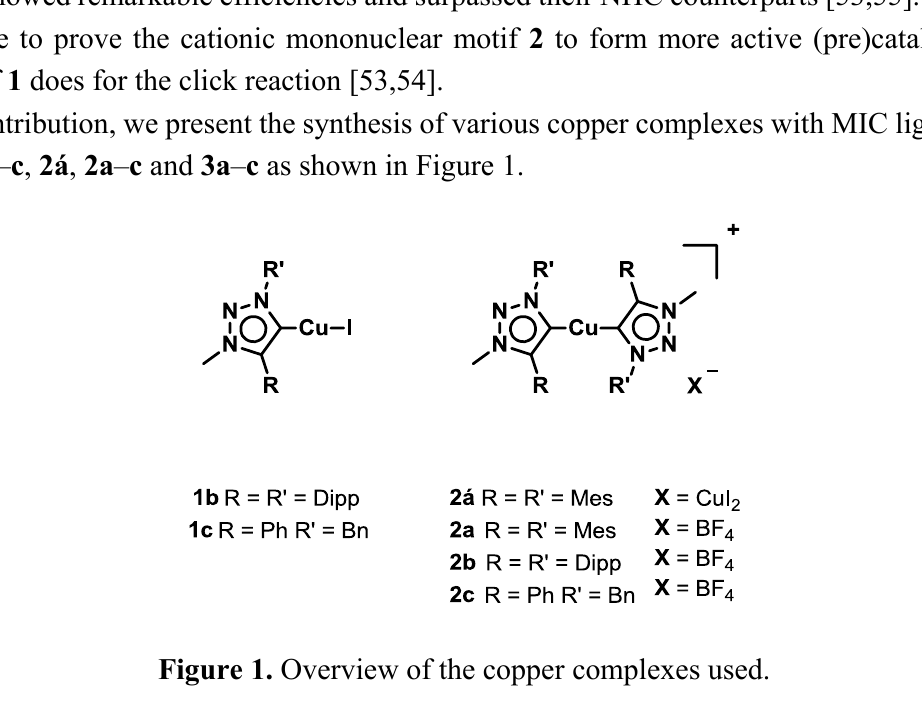
Figure 2. Ligands used in this